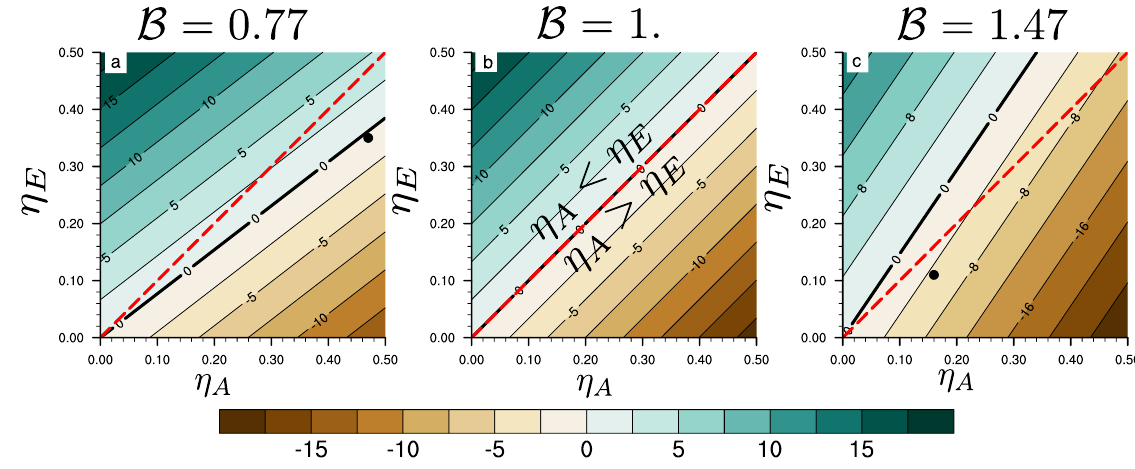
∂P dry Figure 10. Contour plot of (mmm 3 m − 3 ) as a function of η A and η E for different values of the parameter B . The black points in (a) ∂φ dry and (c) are placed using the efficiencies obtained in the ID_ and DA_ cases, respectively. The dashed red line distinguishes the areas where η A >η E and vice versa. Note the symmetric color scale and the thicker zero contour